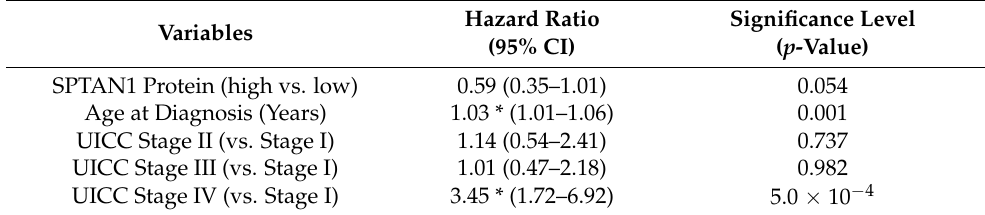
Figure 1. High intratumoural SPTAN1 levels predict better overall survival in patients with CRC. Kaplan-Meier plots depicting the association between overall survival and SPTAN1 protein levels ( a ) in the full cohort from the University Hospital Frankfurt (UHF), and in the subgroups with ( b ) early (UICC stage I/II) or ( c ) advanced (UICC stage III/IV) CRC. The association between overall survival and SPTAN1 gene expression in the TCGA cohort is shown in ( d ). The number at risk is displayed below each survival curve. Patient survival was assessed from the time of diagnosis in the UHF cohort, and from the time of surgery in the TCGA cohort. Survival data were modelled by proportional hazards regression using the survival and survminer packages in the R environment for statistical computing. Results with a p -value < 0.05 were considered statistically significant. Table 1. Overall survival in the Frankfurt cohort analysed by multivariable Cox